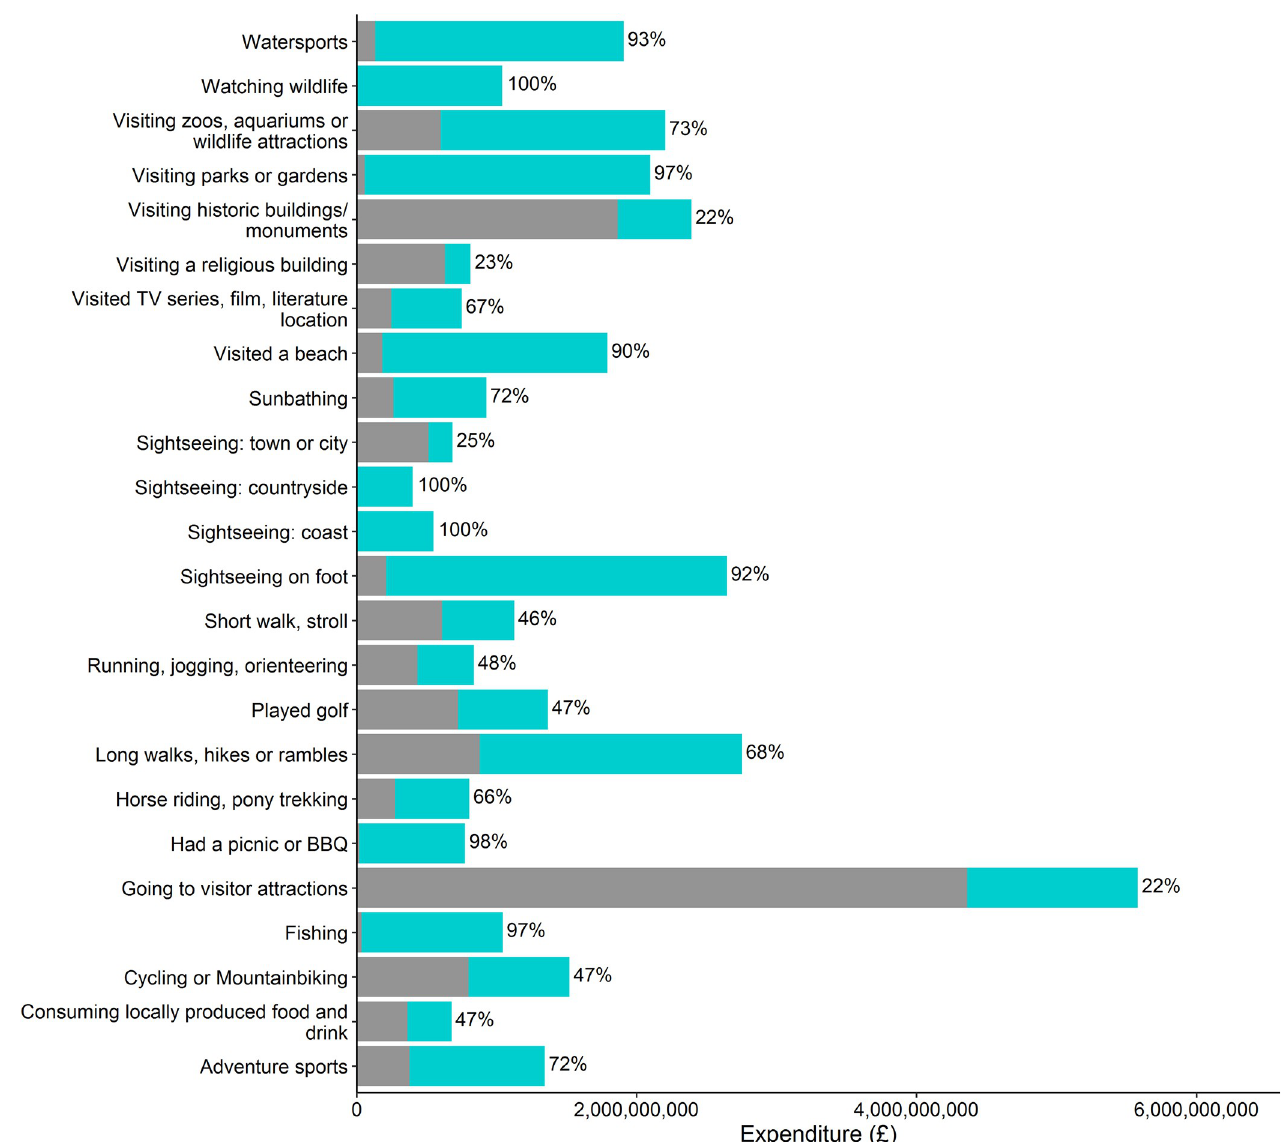
Fig 5. Natural capital contribution per activity. Graph showing natural capital (blue) and other capital (grey) contribution to each activity. The % natural capital contribution is shown at the end of each bar. Activity descriptions have been shortened to enable graph